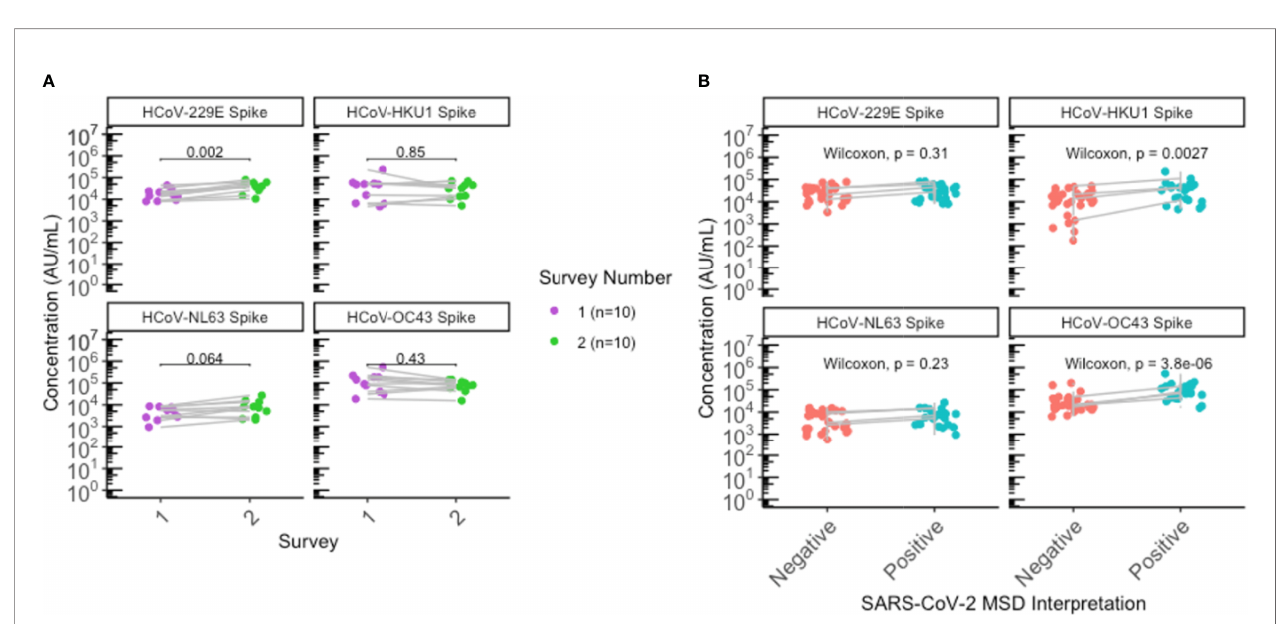
FIGURE 1 | Sero-surveys identi fi ed three new seroconversions and demonstrated gradual waning of anti-nucleocapsid antibodies following the second outbreak. (A, B) Antibody levels for all residents with paired sera collected (N=26) were plotted by SARS-CoV-2 serostatus to assess SARS-CoV-2 antibodies. (A) Commercial serology data plotted according to clinical interpretation. (B) MSD data plotted according to MSD interpretation. (C, D) All participants (N=10) seropositive for SARS- CoV-2 following the fi rst outbreak (purple) remained seropositive following the second outbreak (green) on both (C) commercial and (D) MSD platforms. Grey lines indicate paired samples collected from the same individual from both surveys, and lines on (A, B) traversing across negative (red) to positive (blue) indicate seroconversion, while vertical lines indicate that the individual ’ s paired serum samples both remained seronegative or seropositive across the two surveys. (B, D) Black dashed lines on represent positive signal cut-offfor SARS-CoV-2 S1 RBD (538 AU/mL), spike (1960 AU/mL), and nucleocapsid (5000 AU/mL). Statistical analysis was performed using (A, B) Wilcoxon ’ s Rank Sum Test and (C, D) Wilcoxon ’ s Signed Rank Test.